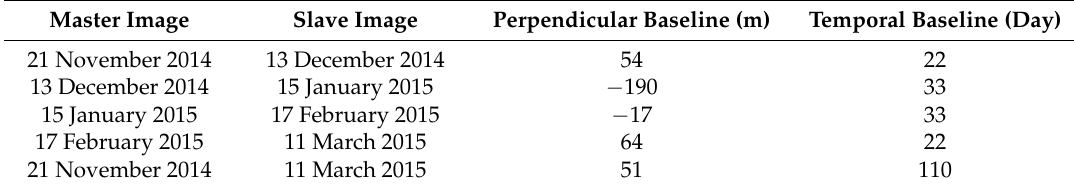
Table 2. The parameters of the five image pairs used in hybrid-SAR processing.